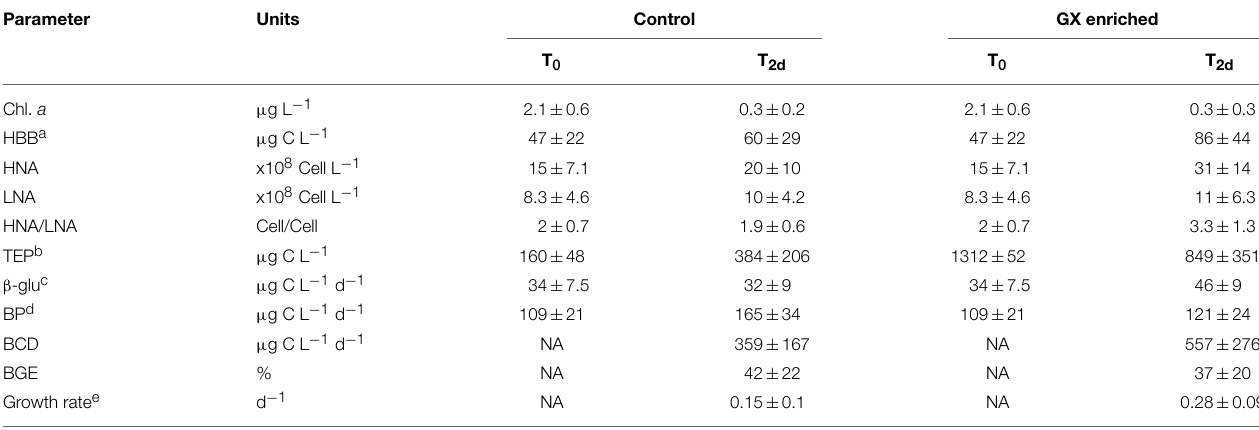
TABLE 2 | Biological properties measured in un-amended controls and gum-xanthan (GX) enriched microcosms incubated 2 days (T 2d ) under dark + DCMU conditions. Parameter Units Control GX enriched T 0 T 2d T 0 T 2d Chl. a µ g L − 1